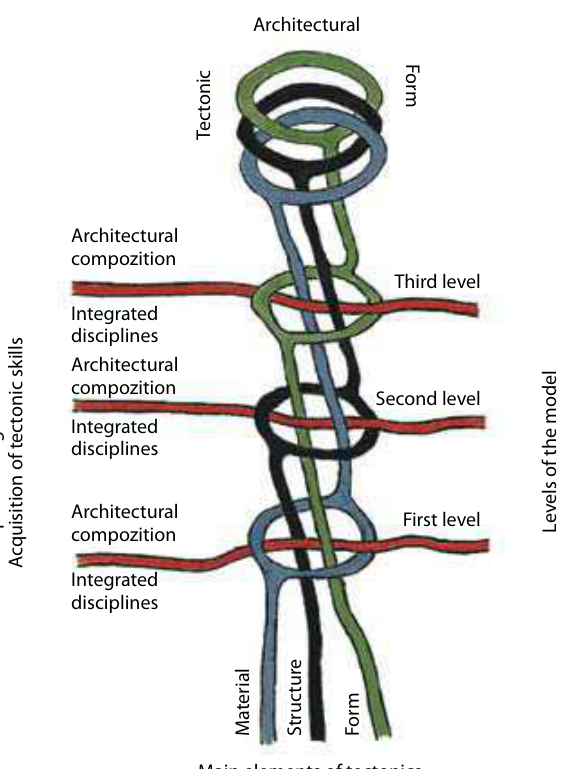
Fig. 1. Model of acquiring tectonic skills (by L. Markejevaitė). Sketchy